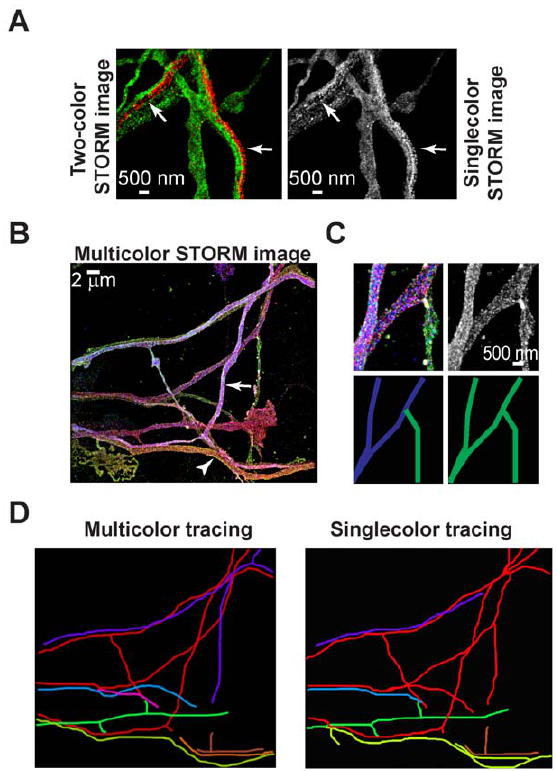
Figure 4. Two-color and multicolor (Brainbow-like) imaging of hippocampal neurons by STORM. (A) A zoomed-in field of view of neural processes with ( left ) and without ( right ) the color information. The neurons were separately transfected with YFP and mCherry, mixed and co-cultured. For the STORM imaging, each fluorescent protein was immuno-stained with antibodies conjugated to different dye pairs. Neural processes that are clearly distinct in the two color images ( left, arrows ) are difficult to distinguish in the absence of color ( right, arrows ). (B) STORM image of neural processes labeled with a combination of three fluorescent proteins. The neurons were co-transfected with a mixture of the three fluorescent proteins. The co-transfection resulted in co-expression of different amounts of each fluorescent protein inside individual neurons and hence to different color combinations. Each fluorescent protein was immuno-stained with antibodies conjugated to different dye pairs. The arrow and arrowhead point to two neural processes that show different color combinations. (C) The STORM image of the same region of neural processes ( upper panels ) is shown in the presence ( left ) and absence ( right ) of color. The tracing results for these two cases are shown in the bottom panels. (D) Tracing results with ( left ) and without ( right ) color information for the image shown in ( B